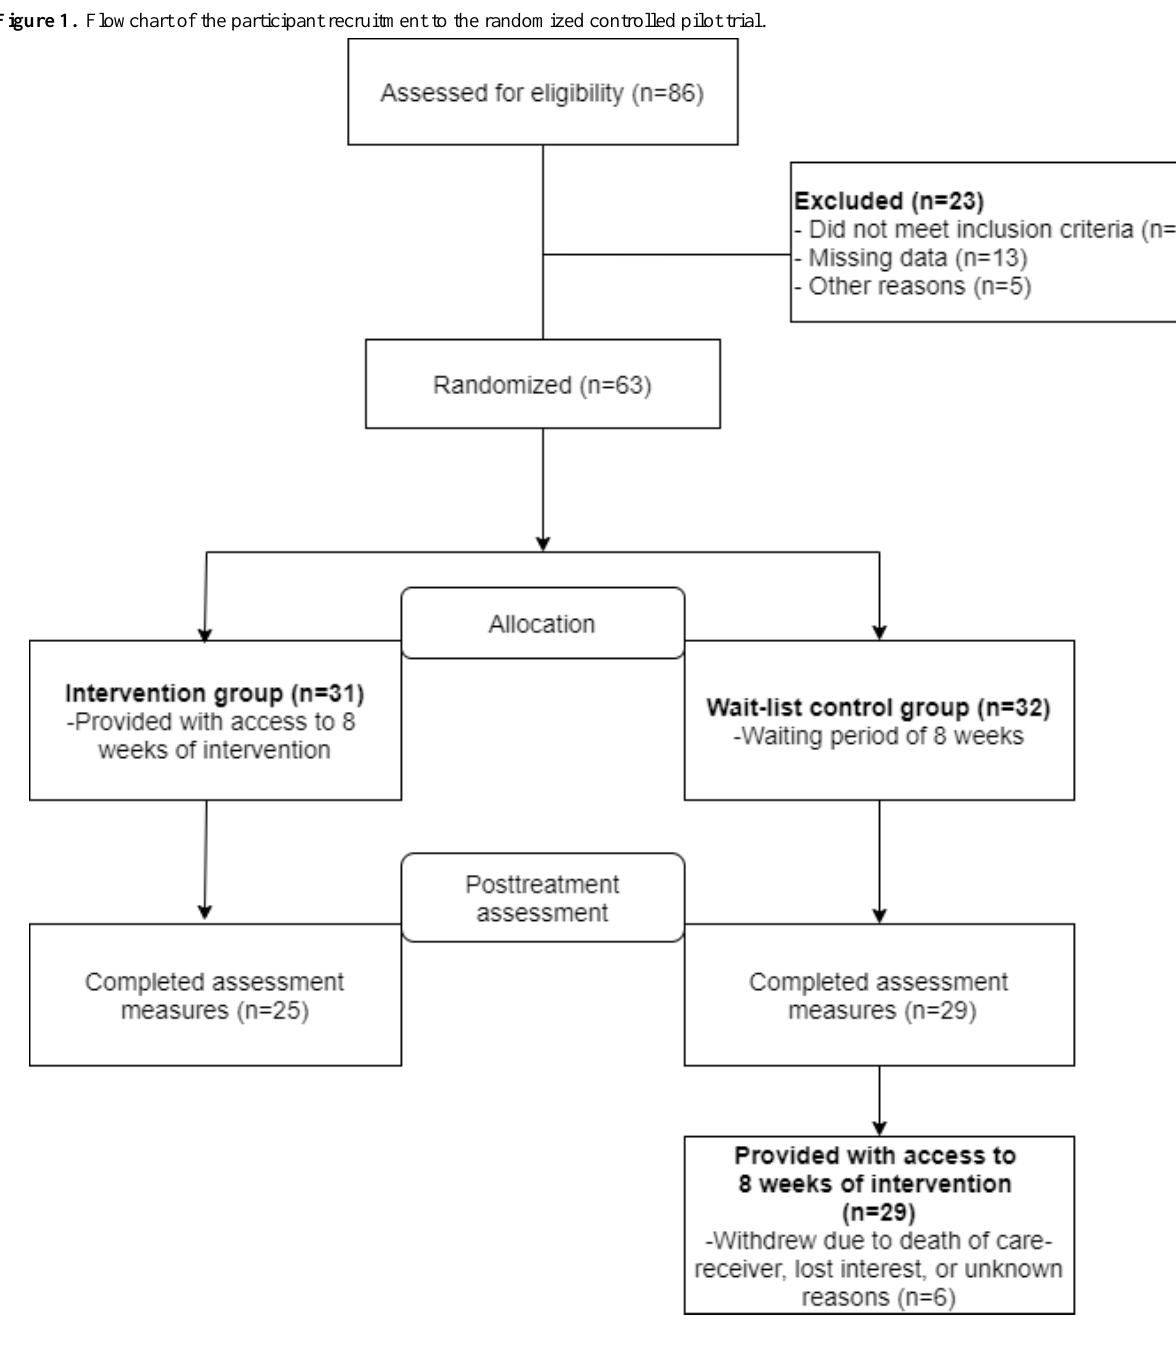
Figure 1. Flowchart of the participant recruitment to the randomized controlled pilot